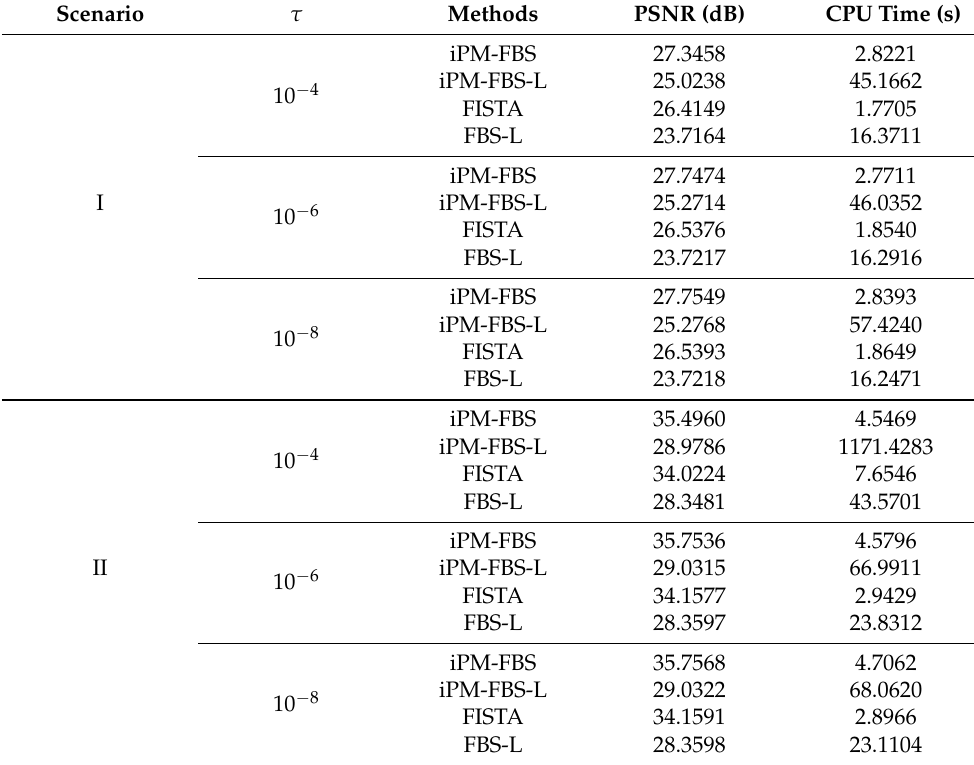
Table 5. The comparison of the PSNR performance of four methods at 200th